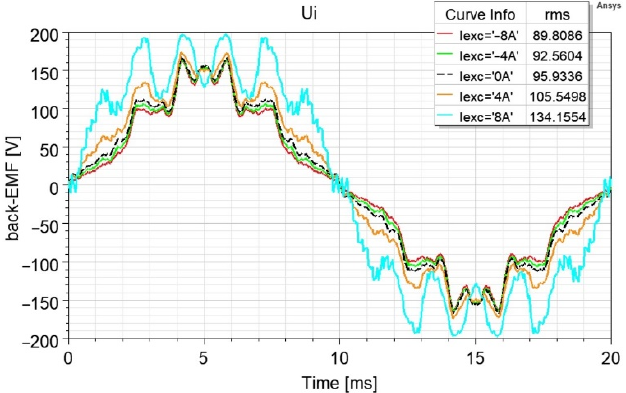
Figure 6. Back-EMF for different DC coil currents.